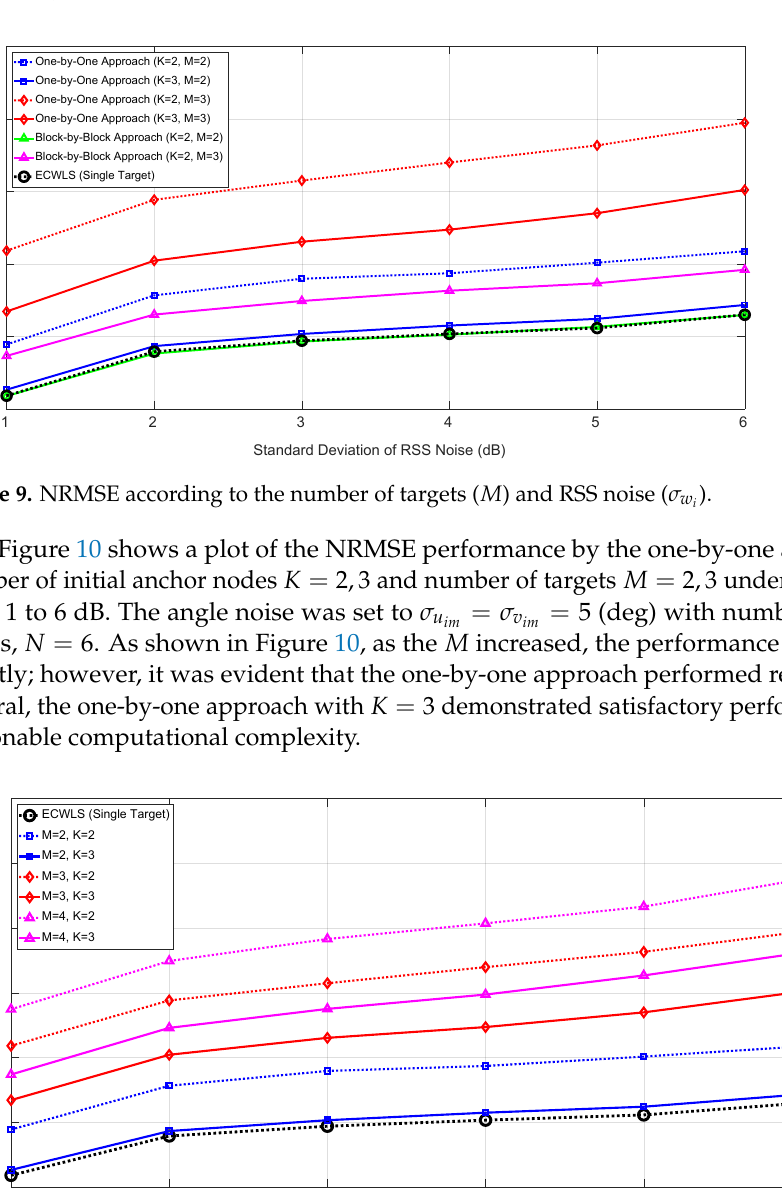
Figure 10. NRMSE vs. the number of targets ( M ) for K = 2 and N = 6 under σ u